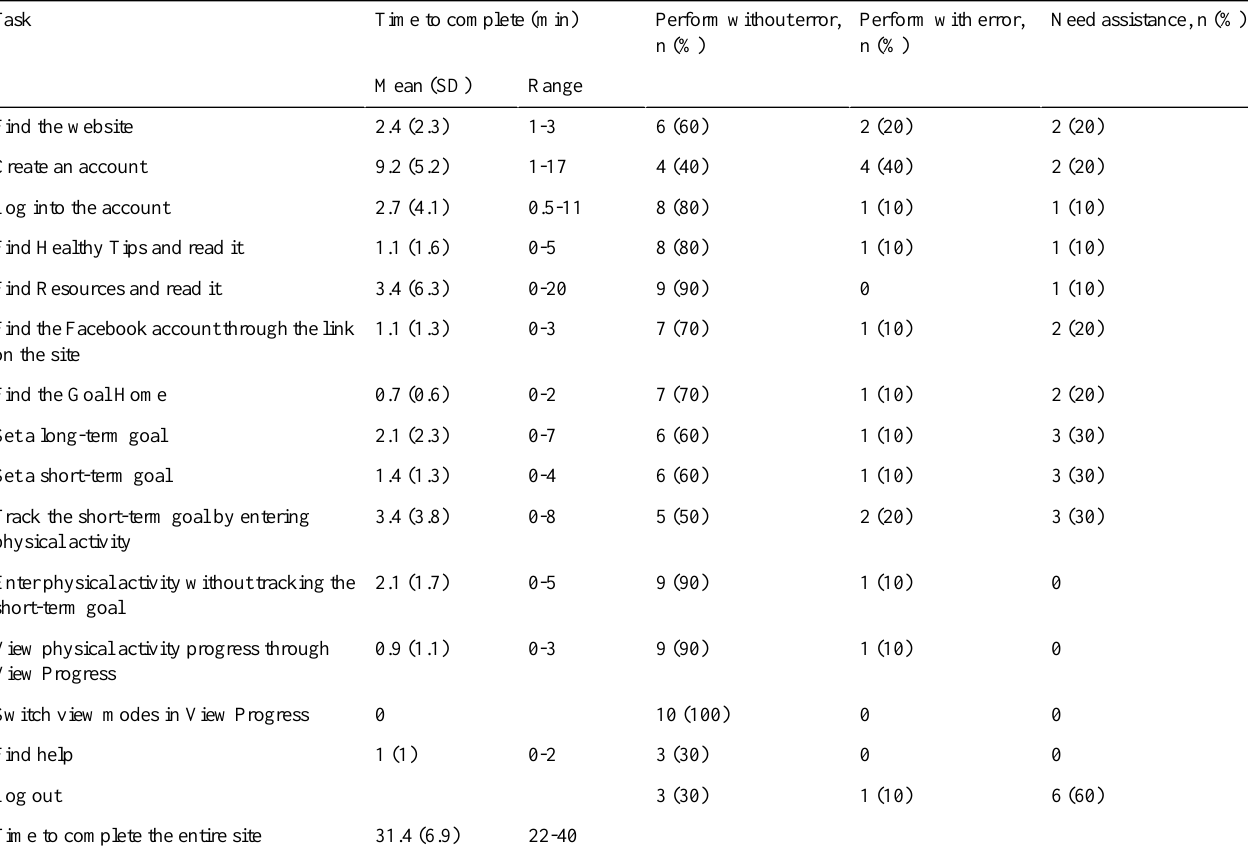
Table 2. Usability testing results of iCanFit (N=10).